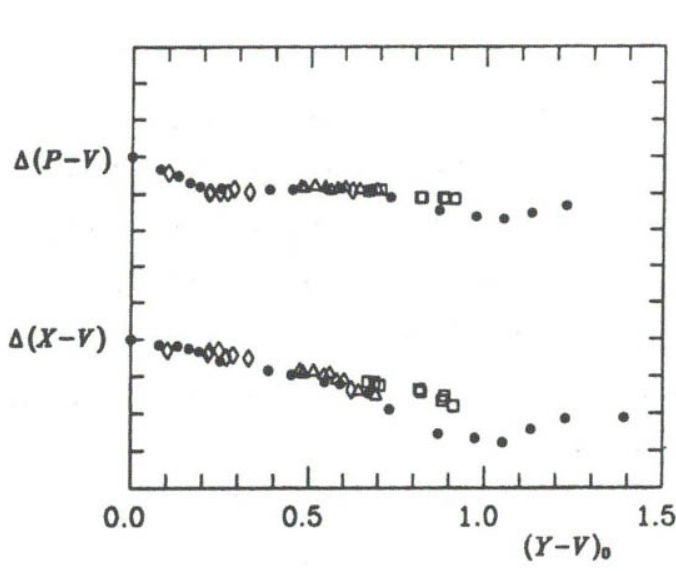
Fig. 3. The differences of synthetic color indices (standard minus CCD) plotted against Y-V. Dots are for main sequence stars, triangles are for subdwarfs, squares are for metal-deficient giants and diamonds are for blue horizontal-branch stars. On both axes the ticks at each 0.1 mag are